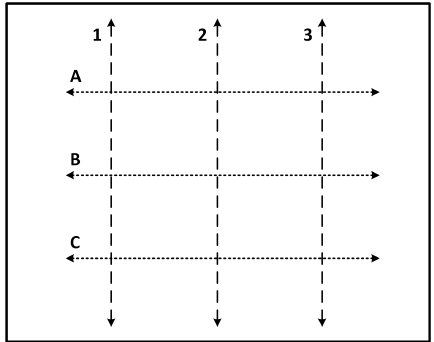
Figure 5. Directions for applying the Wenner array.